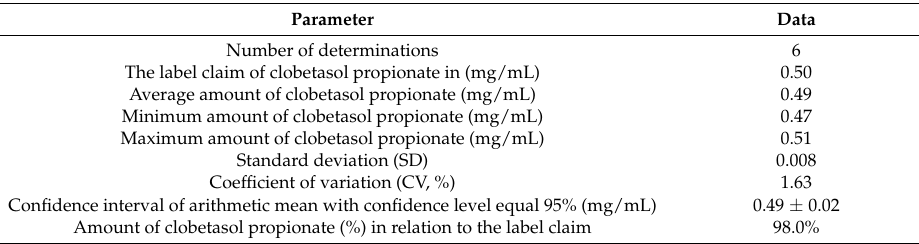
Table 6. Assay of clobetasol propionate by proposed TLC-densitometric method in topical